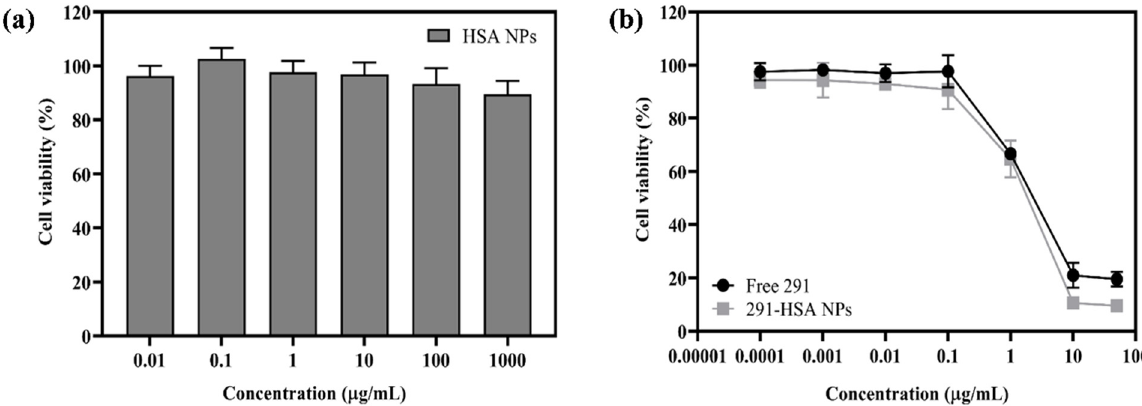
Figure 8. Cell viability of blank human serum albumin (HSA) nanoparticles (NPs) in Mia Paca-2 cells ( a ) and comparison of the cell viability of free MPT0B291 and MPT0B291-HSA NPs in Mia Paca-2 cells ( b ). Each point represents the mean ± SD. Error bars represent the standard deviation ( n = 3).